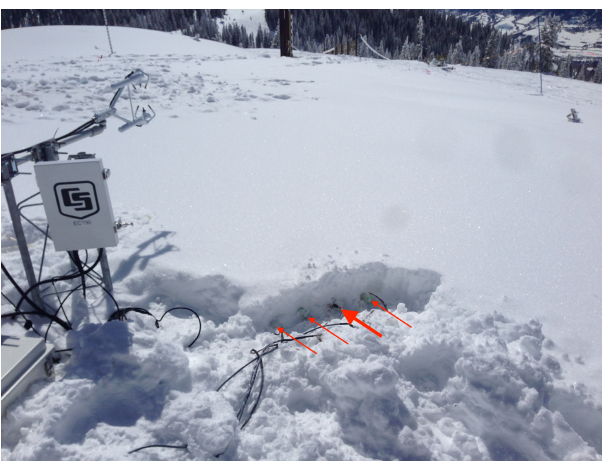
Figure 5. This picture shows the experimental setup for cases 13 and 14 and was taken after the data acquisition period. Red arrows point to the tops of the snow pickets after we removed snow to ex- pose the top and left side of the instrumented snow layer for docu- mentation purposes. The bold red arrow points to the snow picket where the trace gas was released for these two cases. A Campbell Scientific Irgason mounted above the snow pickets acquired hori- zontal and vertical wind speed and direction at